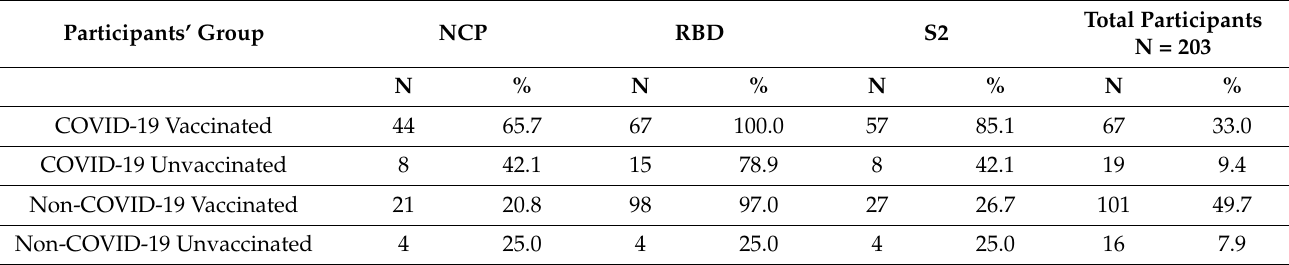
Table 2. Prevalence of NCP, RBD, and S2 antibodies in the studied groups.